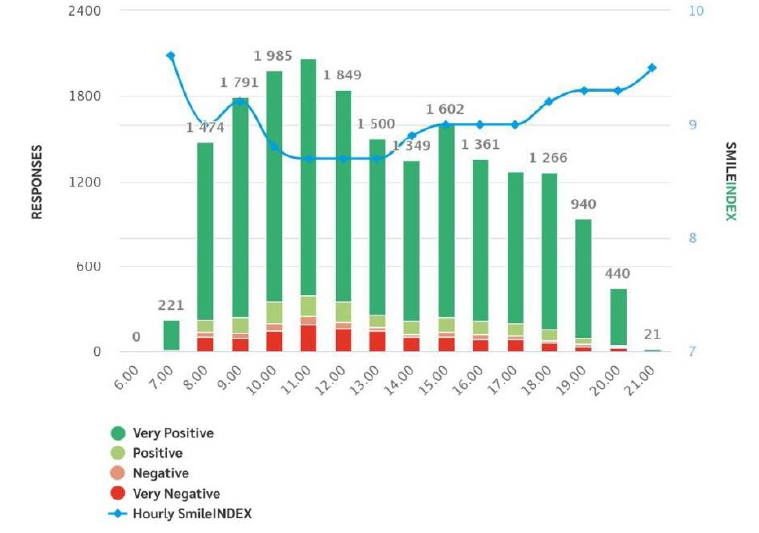
Figure 2. Trends by hour.